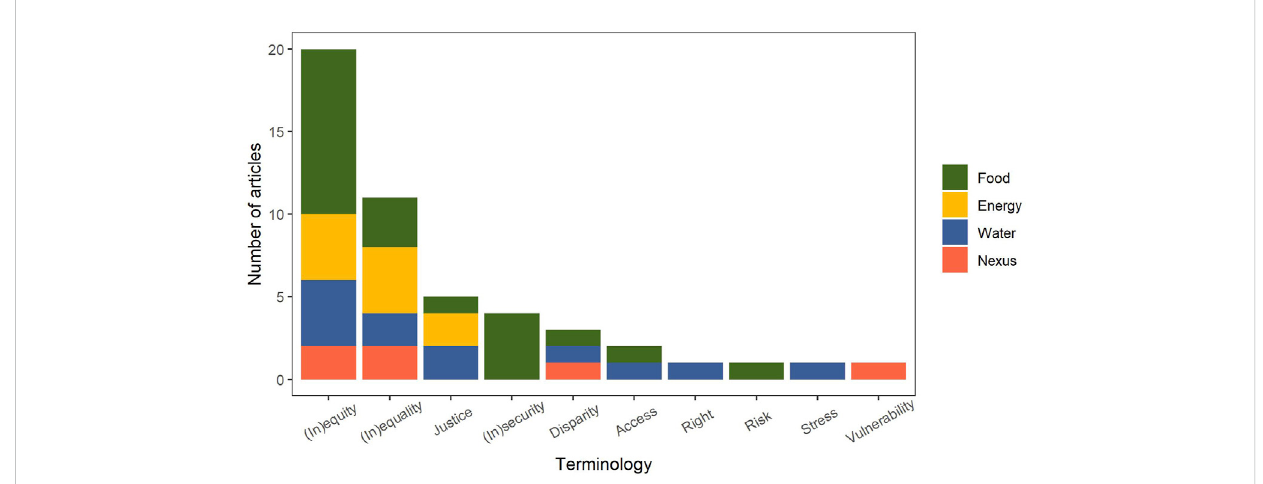
FIGURE 4 Equity terms found in articles included in this literature review, with number of articles using each and the system focus (food, energy, water, nexus) for each